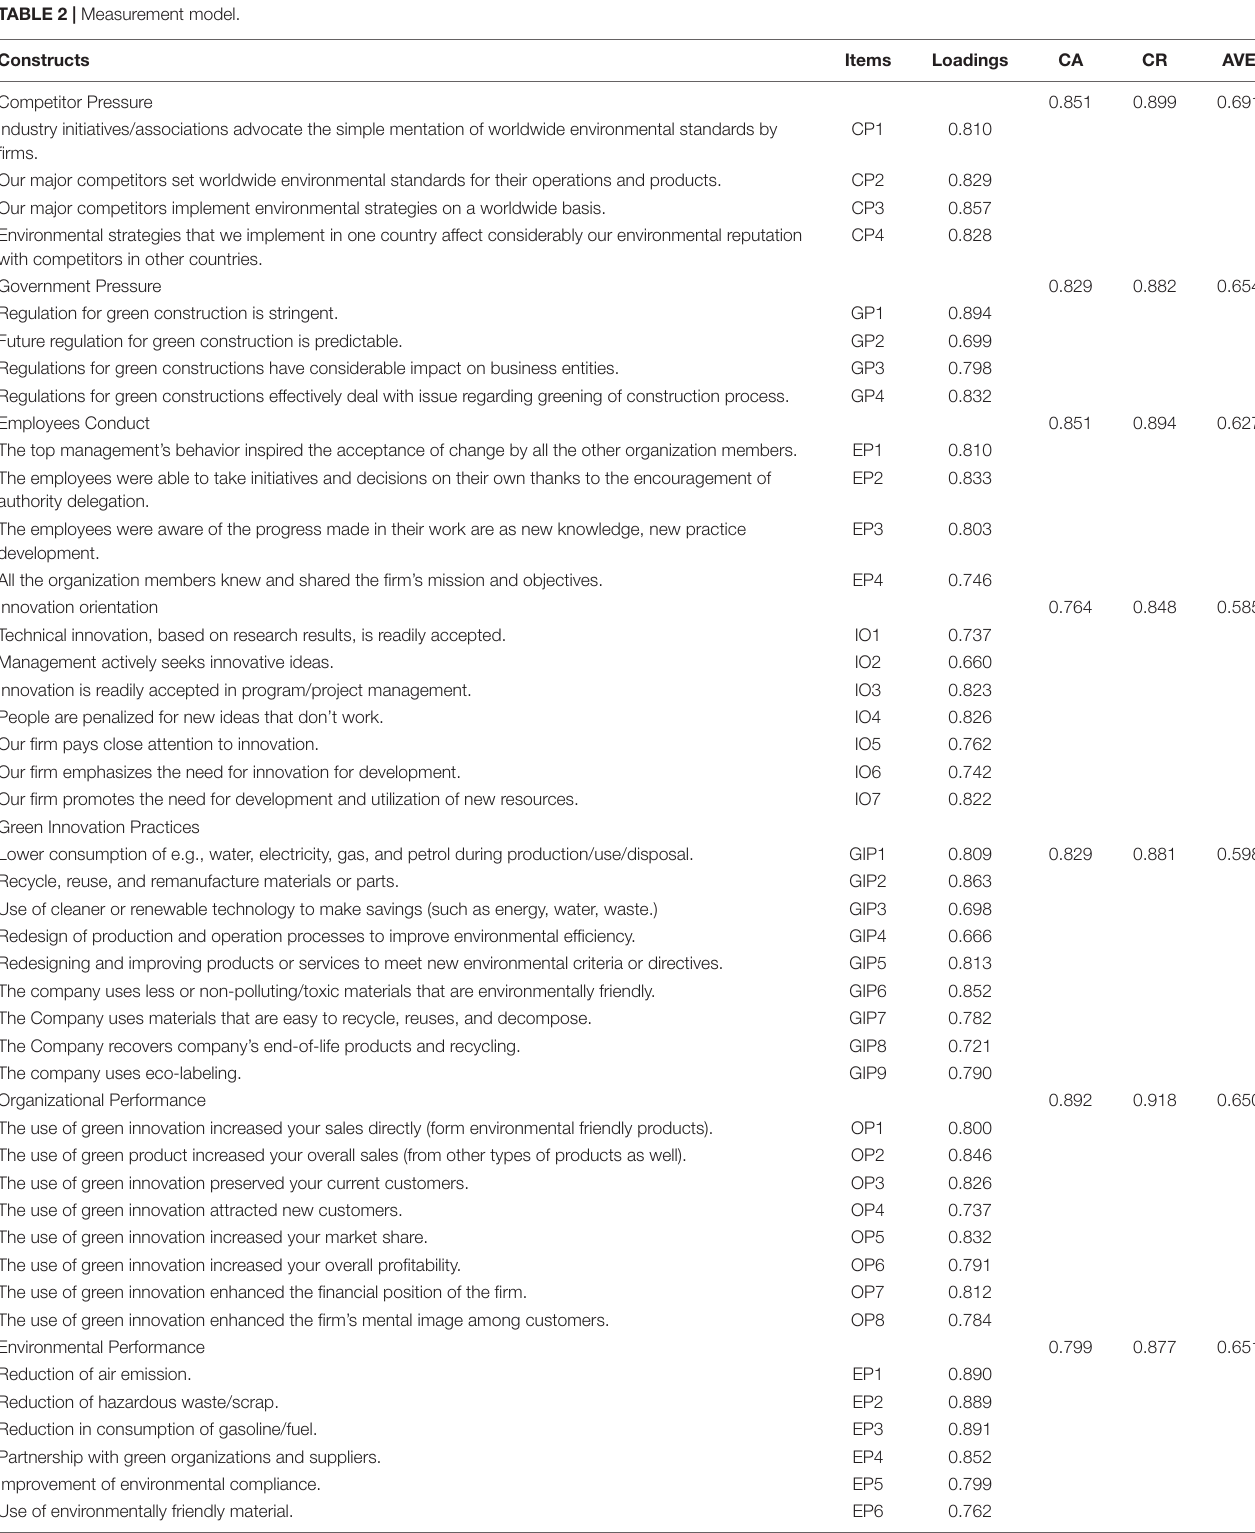
TABLE 2 | Measurement